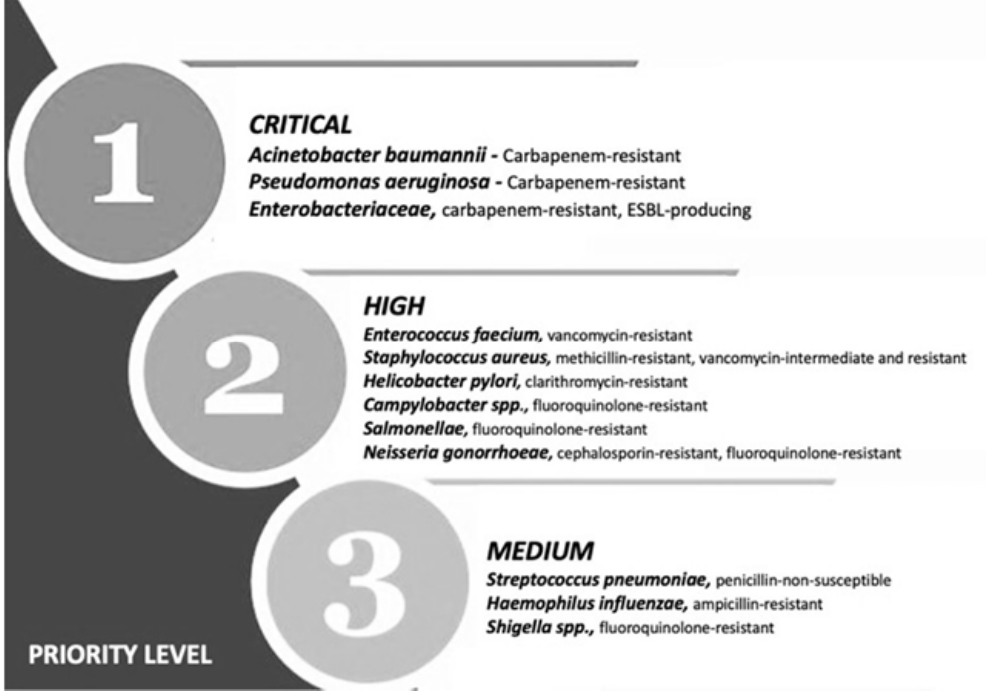
Figure 1. Priority list for development of new antibiotics according to the World Health Organization. Adapted from (Zyman A; et al., 2022) [6].